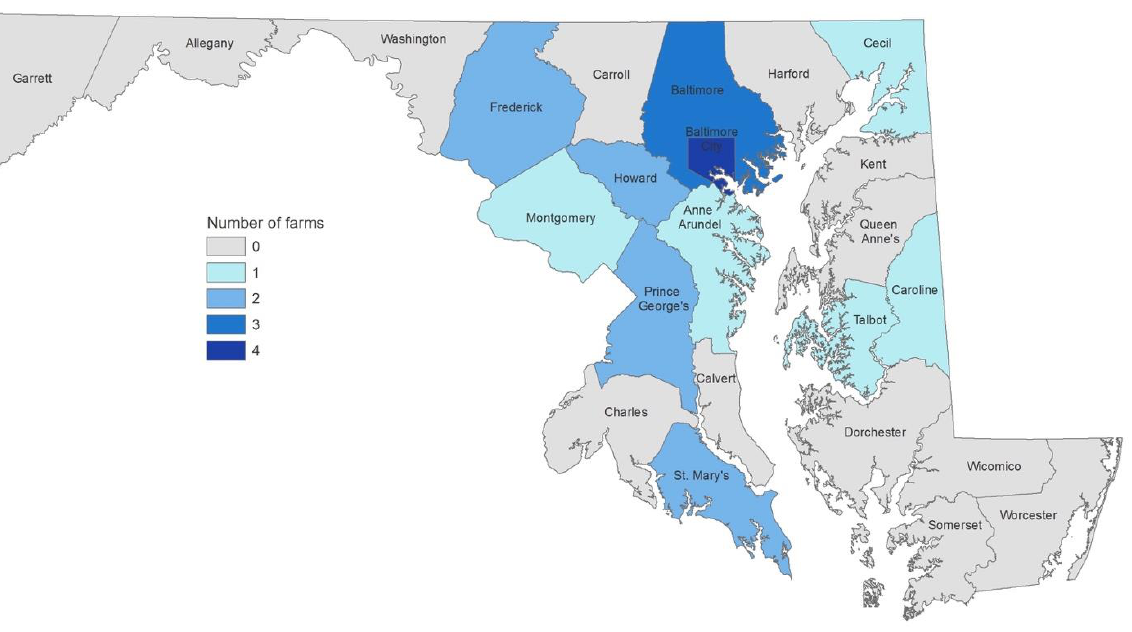
Figure 1. Participating Farm Locations by County in